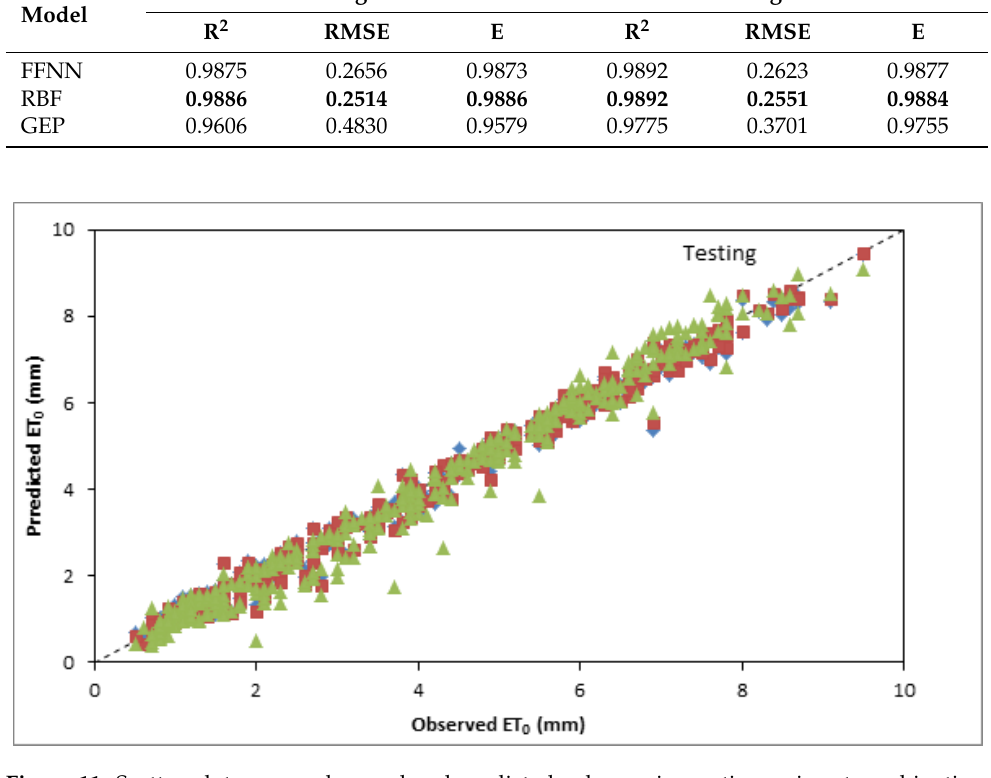
Figure 11. Scatter plot among observed and predicted values using optimum input combination-based models using testing data set. Table 11. Statistical criteria for the optimum combination of inputs. Table 12. Single-factor ANOVA results for the optimum combination of